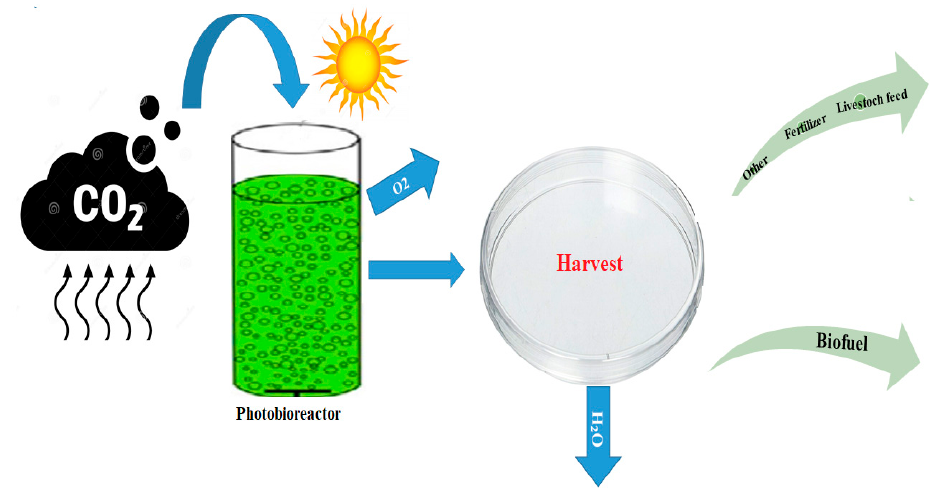
Figure 1. Green conversion of CO 2 to biofuel. Table 1. Some biological control applications for carbon dioxide stabilization and bioconversion into renewable fuels.